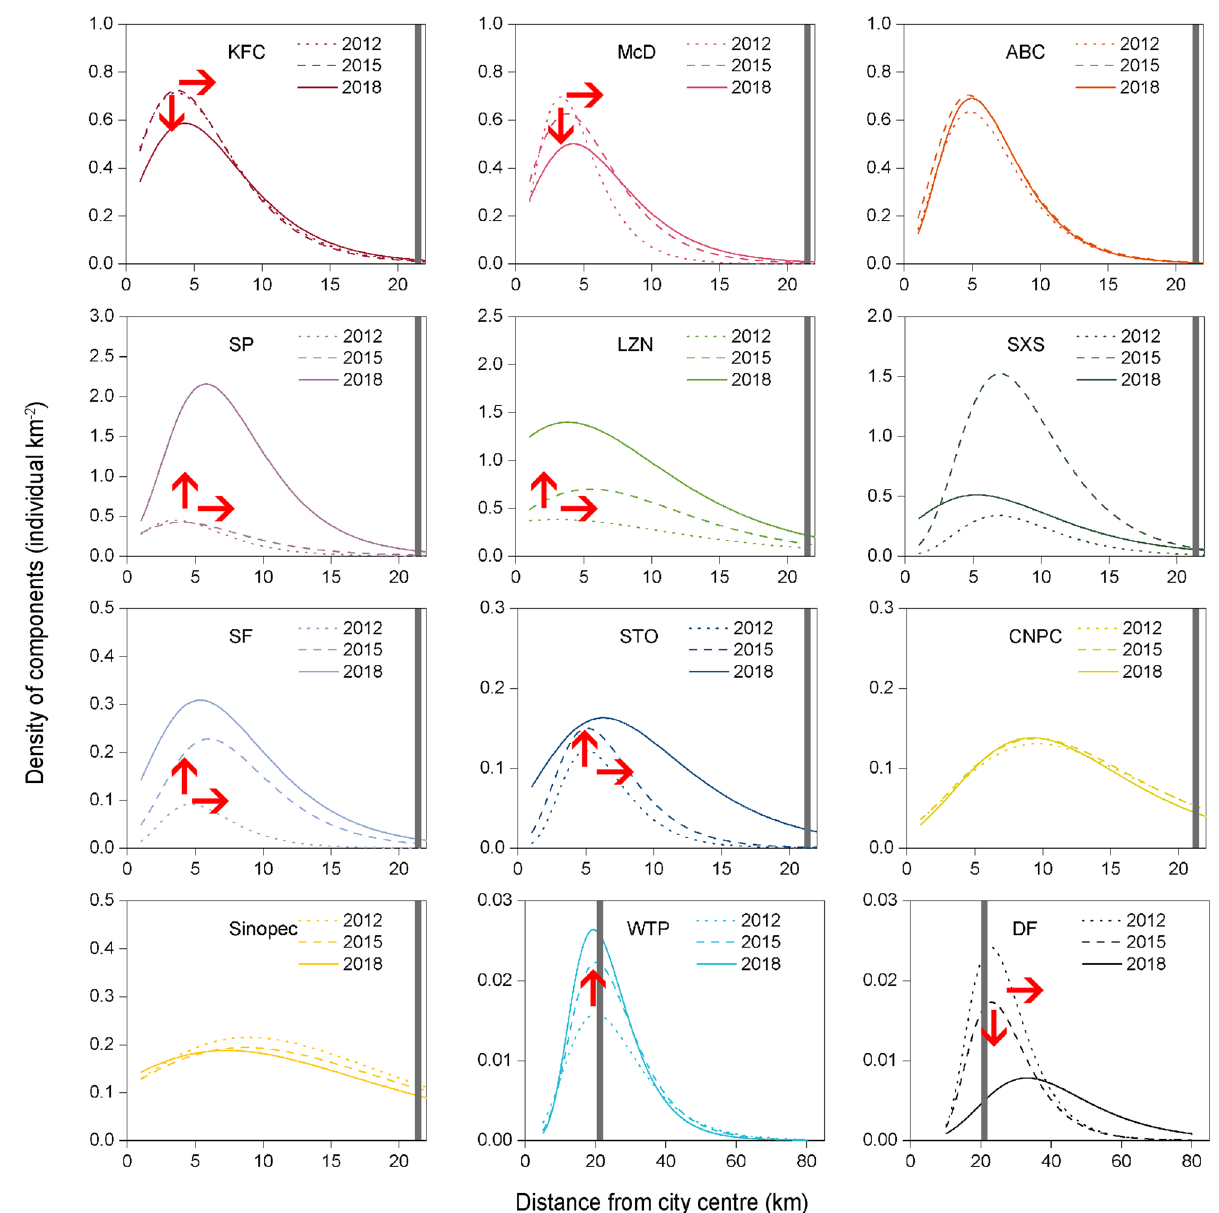
Figure 5. Dynamic changes in the density distribution curves of the city functional components along the urban–rural gradient over time (Beijing). The arrow indicates the change trend of the density distribution curve of the city functional components. The grey band indicates the boundary of the urban built-up area. The abbreviations of the component names are the same as those in Fig.